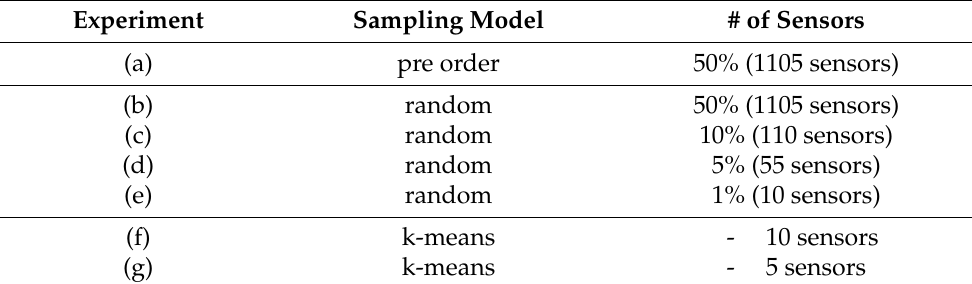
Table 1. Sampling scenarios used in experiments (a) to